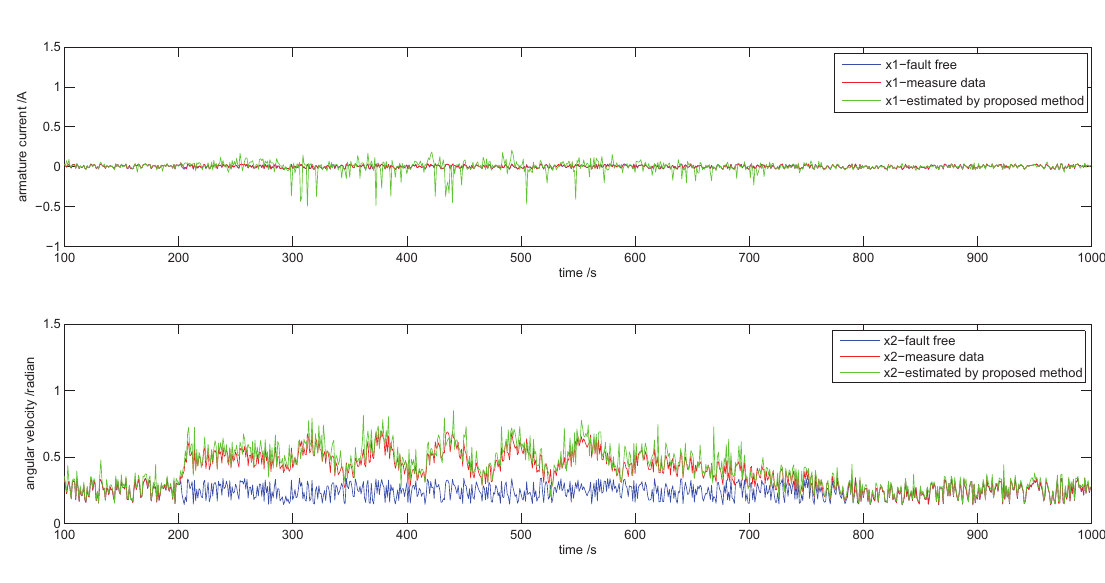
Figure 8. The evolution of